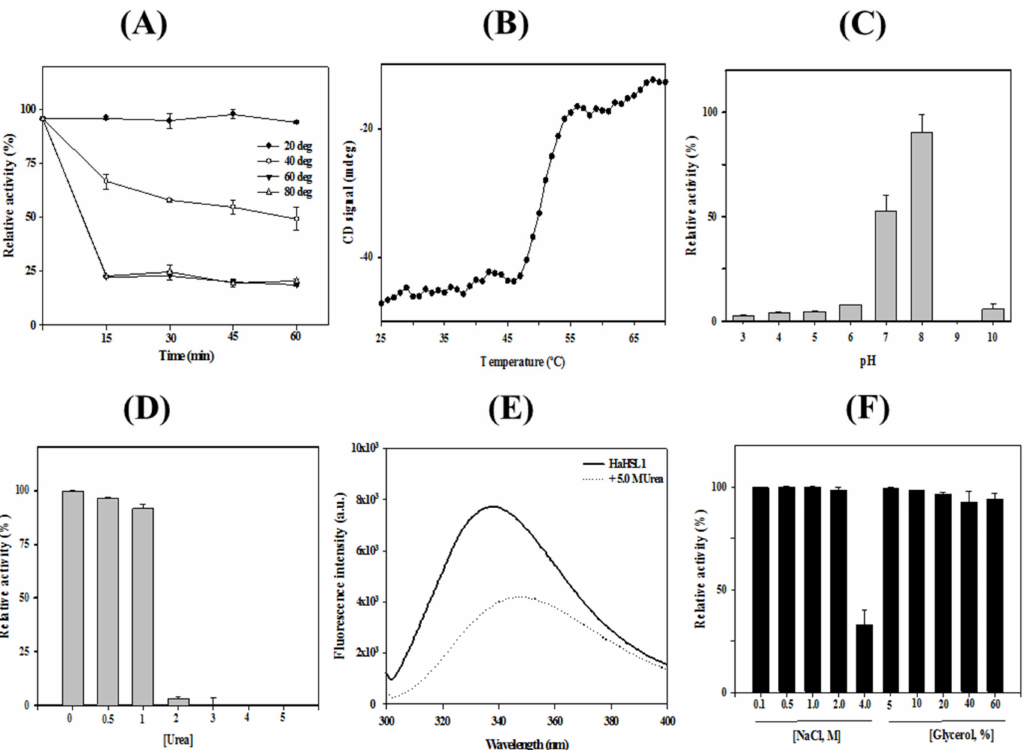
Figure 3. Stability of Ha HSL. ( A ) Thermal stability of Ha HSL was investigated at 20 ◦ C, 40 ◦ C, 60 ◦ C, and 80 ◦ C for 1 h. ( B ) Thermal unfolding of Ha HSL was monitored using CD analysis at 222 nm. ( C ) pH stability of Ha HSL was investigated from pH 3.0 to pH 8.0. ( D ) Activity of Ha HSL in the di ff erent concentrations of urea. ( E ) Urea-induced unfolding of Ha HSL was investigated using intrinsic fluorescence spectra. ( F ) Activity of Ha HSL in the presence of various concentrations of NaCl and glycerol. All experiments were performed at least in